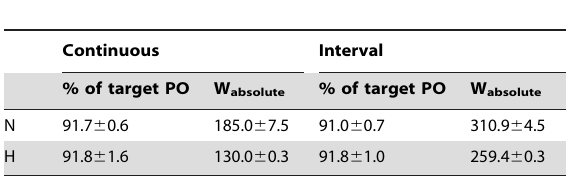
Table 2. Averaged percentage (Mean 6 SE) of target power output (target PO), i.e . 100% PPO for interval sessions and 60% of VO 2max and the averaged absolute power output (W absolute ; W) for continuous training sessions, of Normoxic (N, n = 8) and Hypoxic (H; n = 10) groups.